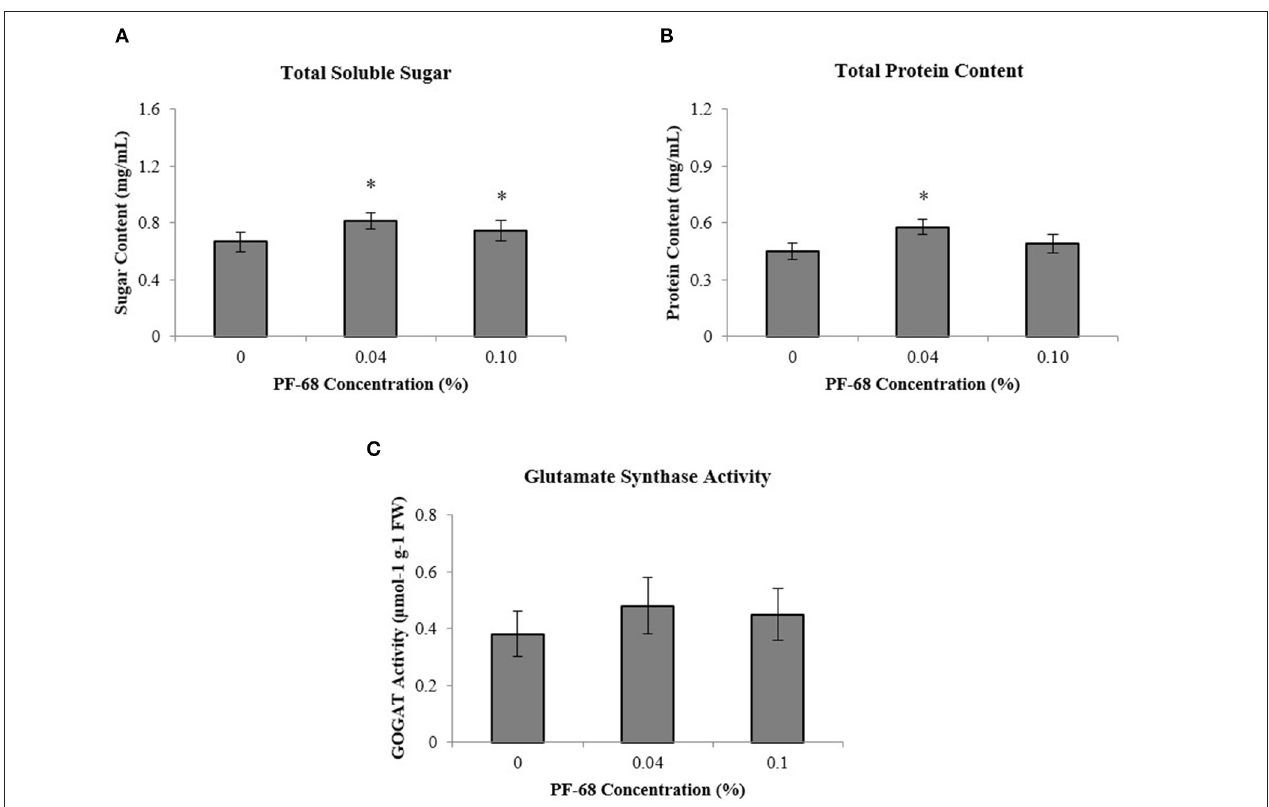
FIGURE 2 | Biochemicals analysis was performed on extracts of calli grown on Murashige and Skoog (MS) medium supplemented with different PF-68 concentrations without plant hormones (MSO). Control (MSO), optimum (MSO + 0.04% PF-68), and high (MSO + 0.10% PF-68). (A) Total soluble sugar; (B) total protein content; (C) glutamate synthase (GOGAT) activity. Data shows the mean of three biological replicates. Asterisks (*) indicate values were significantly different from those of the control callus at p < 0.05. Error bars represent SD of three biological